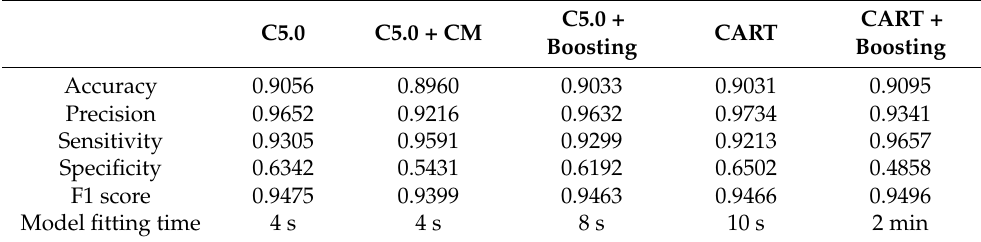
Table 15. Positive = no confusion matrix evaluation